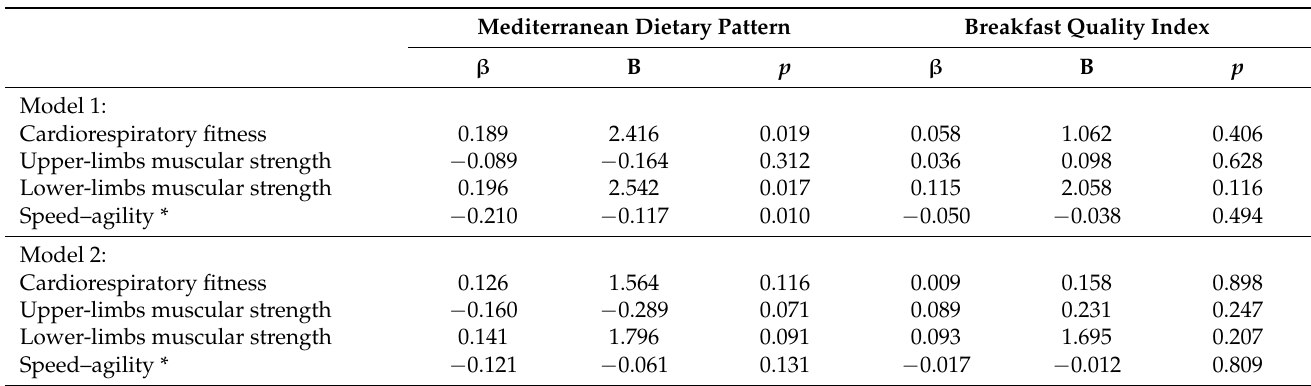
Table 2. Linear regression analysis between the Mediterranean dietary pattern and breakfast quality with physical fitness